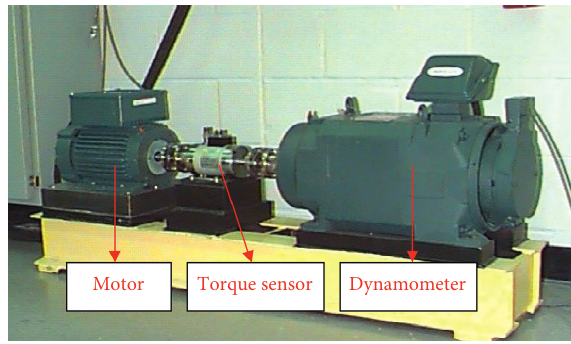
Figure 4: The mechanical failure simulation test